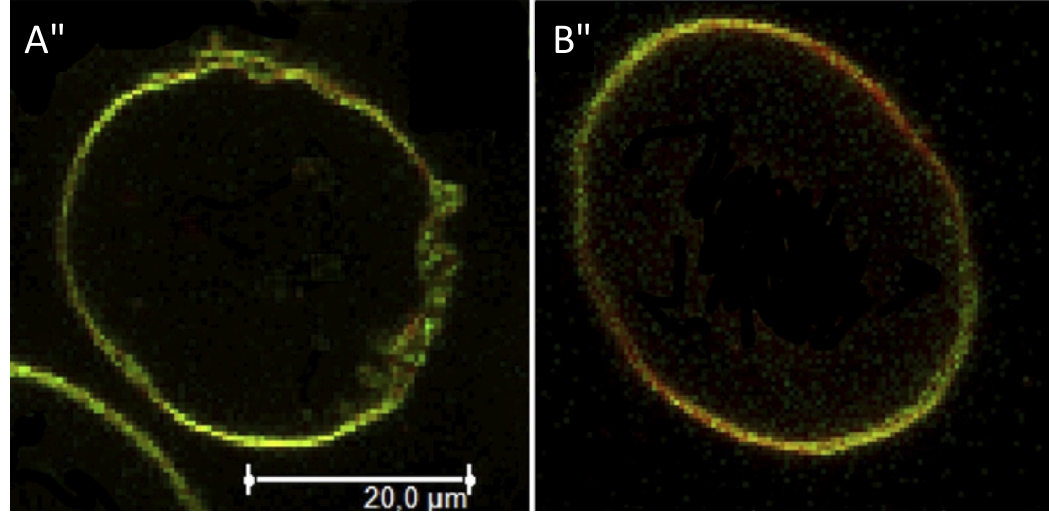
Figure 3. Confocal scanning fluorescence microscopy images for giant unilamellar vesicles containing β -diglycolipid 15 at 22 °C ( A ) and 37 °C ( B ). Vesicles composed of DMPC/DMPS/ 5 labeled with 0.1% DiI C18 (green) and 0.1% DiIC18 (red) were prepared as described in the supporting information. Color merged images were